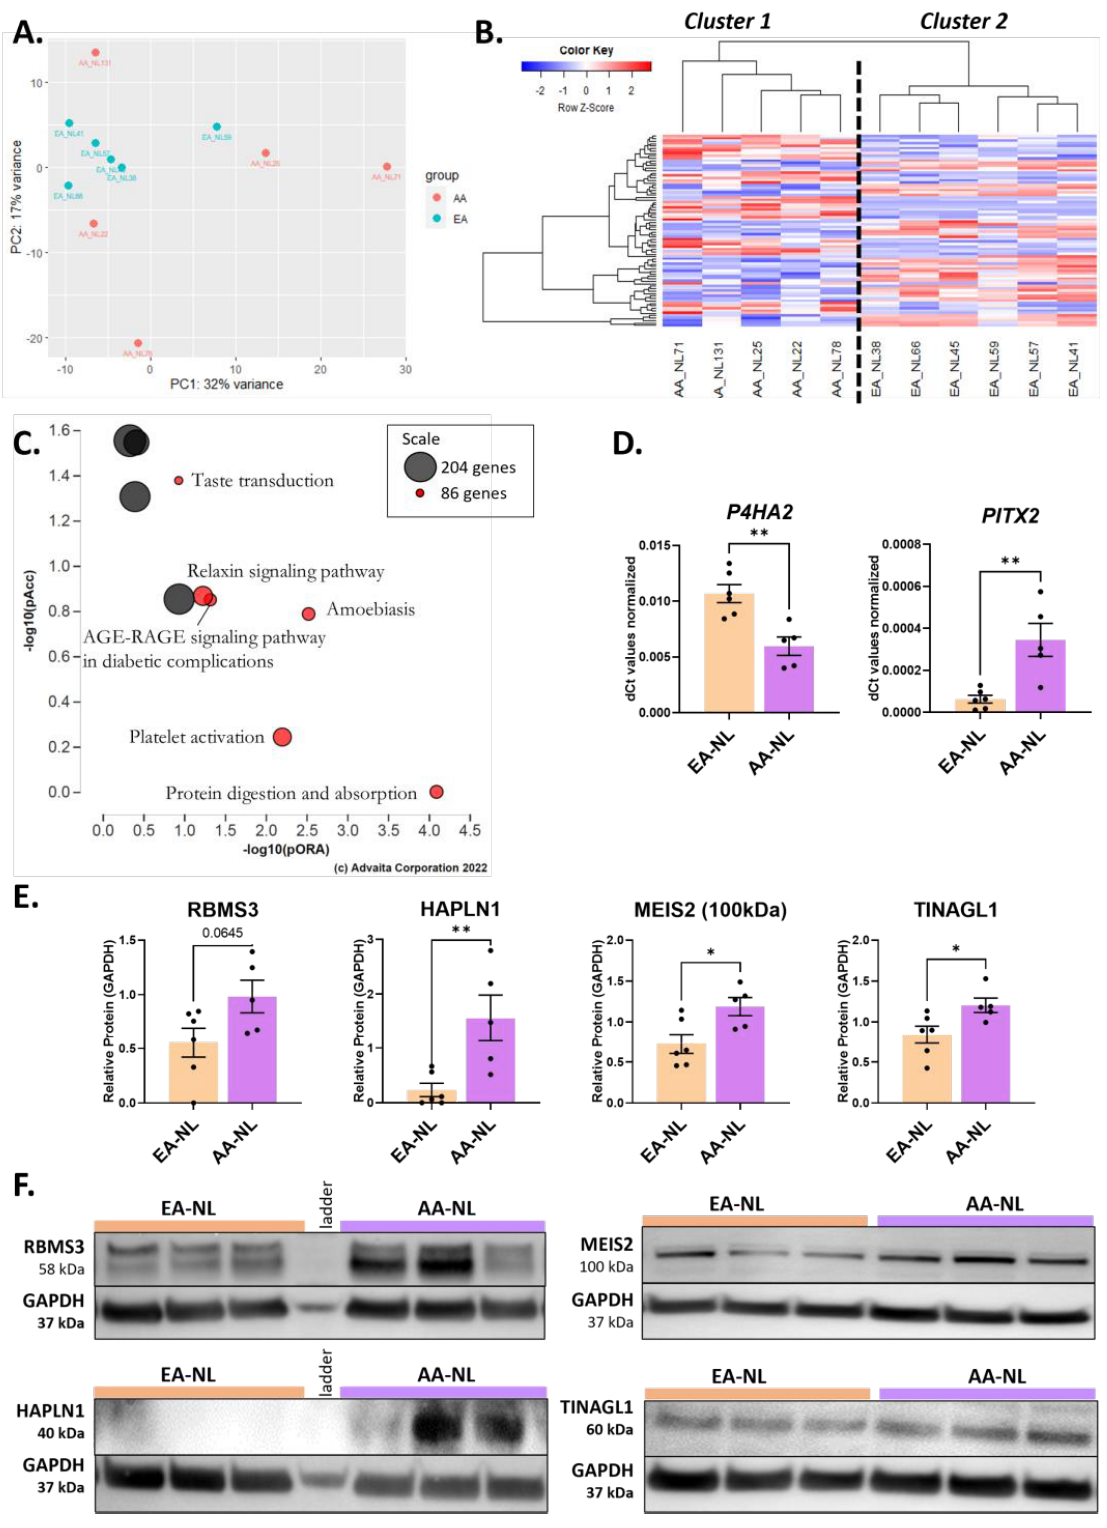
Figure 1. Differential expression analysis between AA-NL and EA-NL. ( A ) PCA plot for “AA-NL vs. EA-NL” DE analysis. ( B ) Heatmap of the genes with a q-value < 0.1 in the “AA-NL vs. EA-NL” DE analysis. ( C ) Perturbation vs. over-representation pathway plot. Dots representing the top 6 impacted pathways are positioned by their p -values from two different analyses: the impact analysis (pAcc) vs. the over-representation analysis (pORA). The size of each plot denotes the total number of genes in the corresponding KEGG pathway (for visualization, this number is log(2) scaled). ( D ) Expression levels of P4HA2 and PITX2 in AA-NL fibroblasts compared to EA-NL fibroblasts. ( E ) Protein abundance of RBMS3, HAPLN1, MEIS2 (100 kDa band), and TINAGL1 in AA-NL fibro- blasts compared to EA-NL fibroblasts, normalized to GAPDH loading control. ( F ) Representative